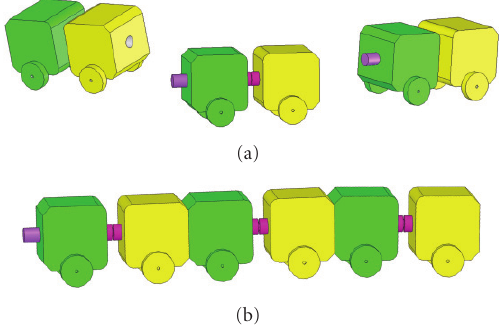
Figure 1: The main idea of the work: (a) each module is equipped with a docking connector and a universal joint; (b) the modules can dock and couple together using their connection